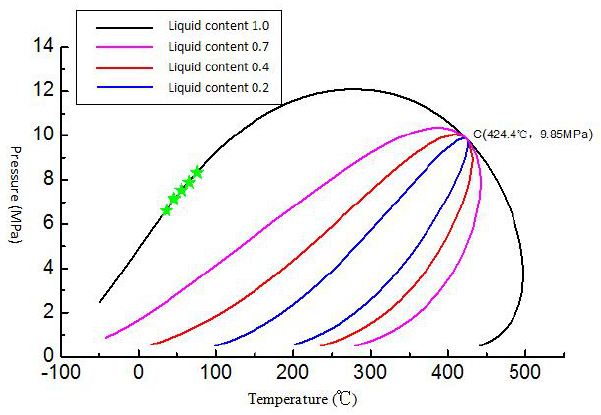
Figure 3—P-T simulation of crude